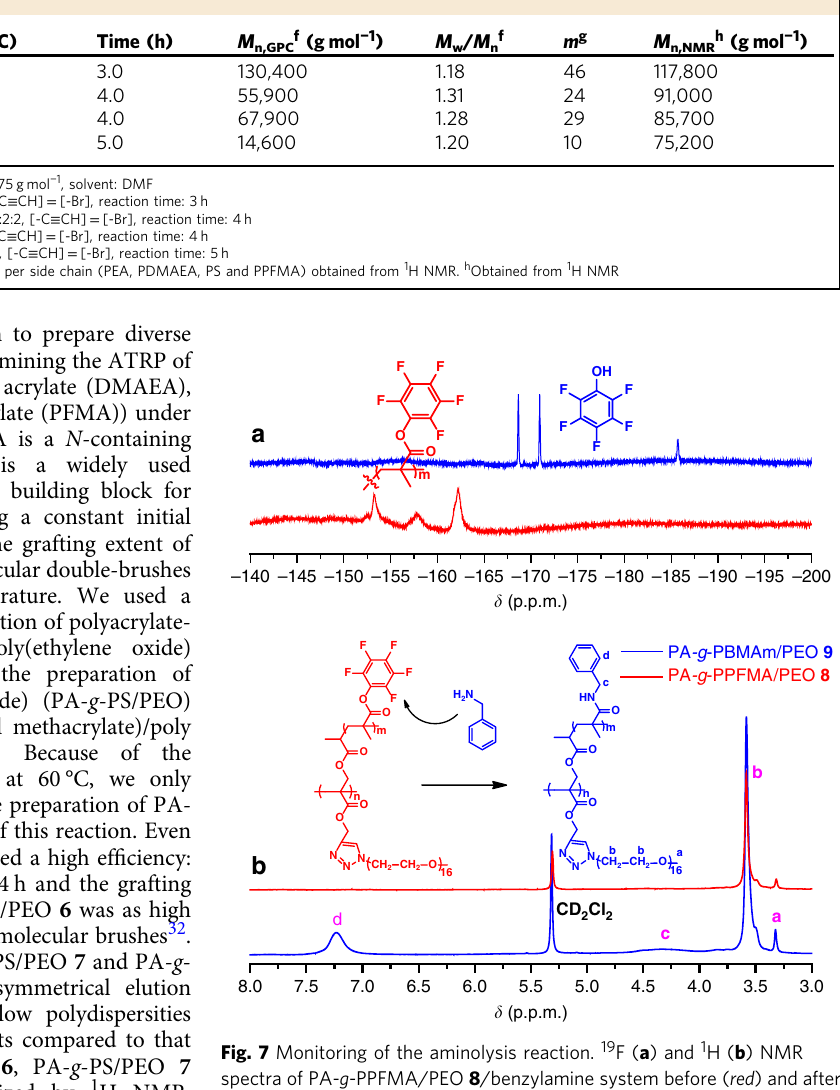
Table 1 Synthesis of asymmetric molecular double-brushes a